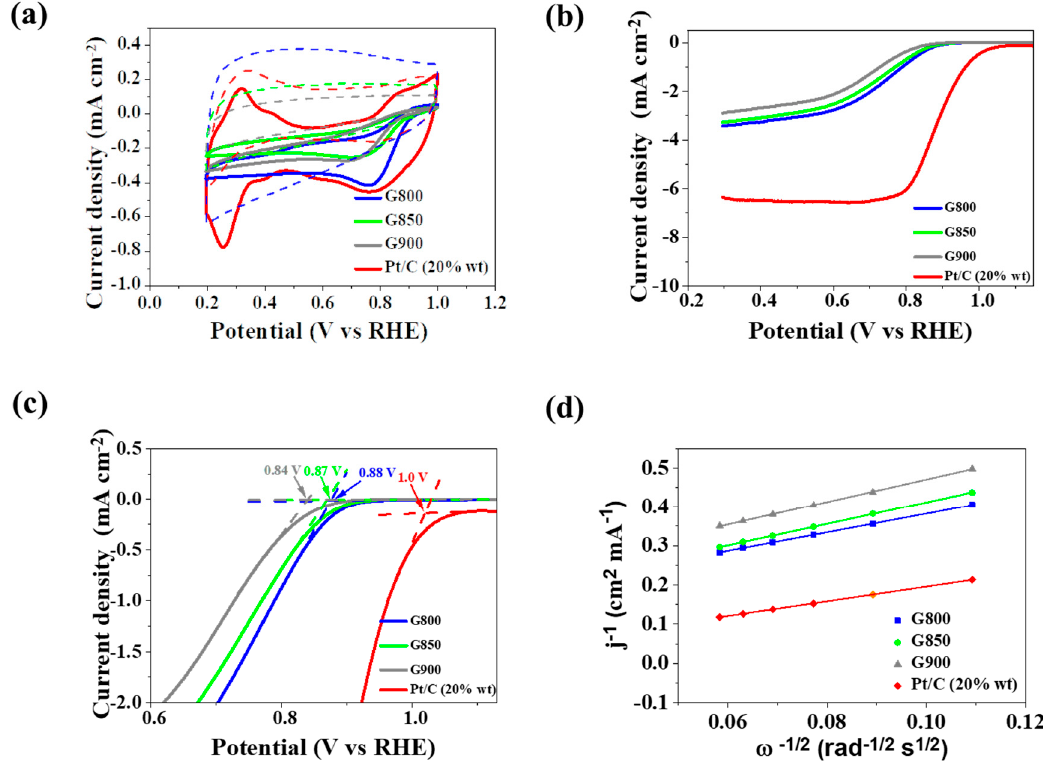
Figure 4. ( a ) Cyclic voltammetry (CV) curves recorded at 100 mV s − 1 under N 2 (dashed line) and O 2 flow for the GX series and Pt/C catalyst; ( b ) Linear sweep voltammetry (LSV) curve of the prepared samples (10 mV s − 1 , 1600 rpm) for GX series and Pt/C catalyst; ( c ) Onset potential determination in expanded LSV curves; ( d ) Koutecky-Levich plot for the commercial Pt/C catalyst and GX series at +0.50 V.